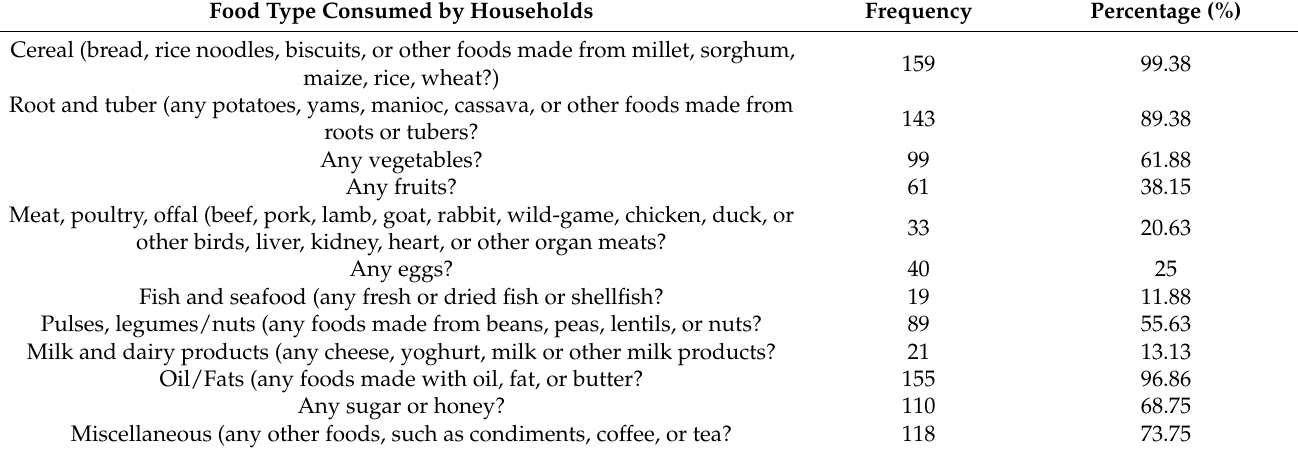
Table 3. Food groups consumed by households with children in the Inanda Informal settlements in a 24-h recall period.